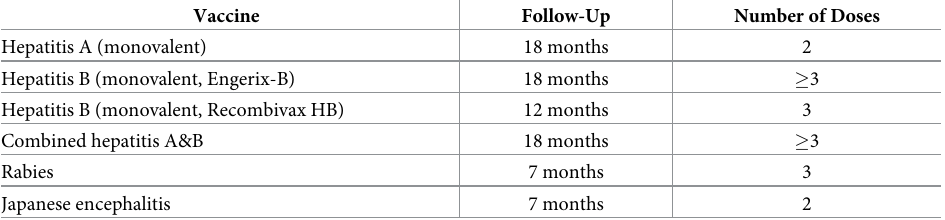
Vaccine Follow-Up Number of